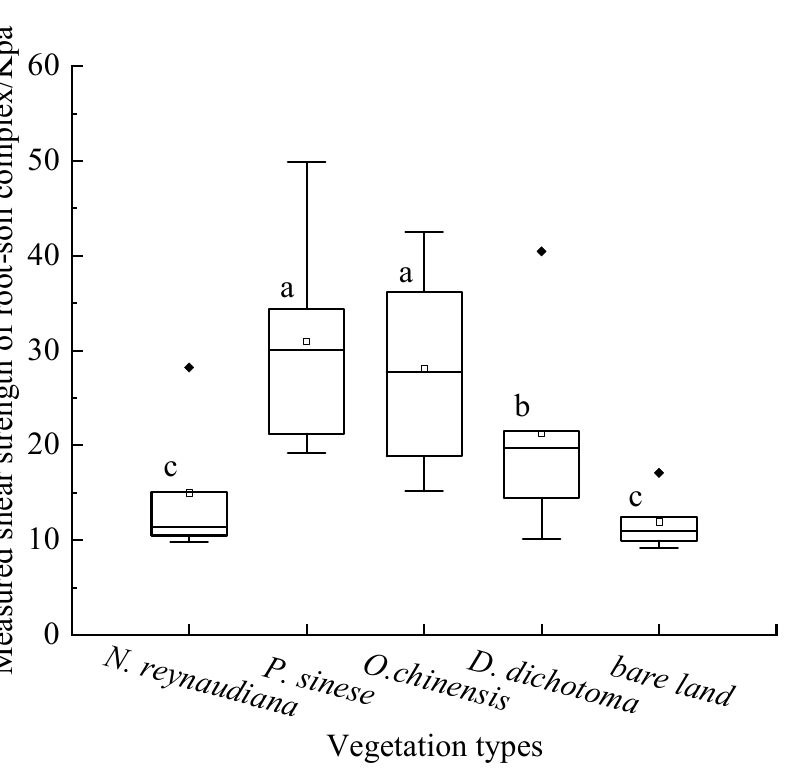
Figure 7. Comparison of soil shear strength under different vegetation types. Each box indicates the 25th/75th percentiles. The whisker caps represent the 10th/90th percentiles. The median is depicted by the line and the mean value is depicted by the square. For each vegetation, significant dierences between experiments are denoted by different letters, such as a and a means no significant difference ( p > 0.05), a–c means significant differences ( p < 0.05).